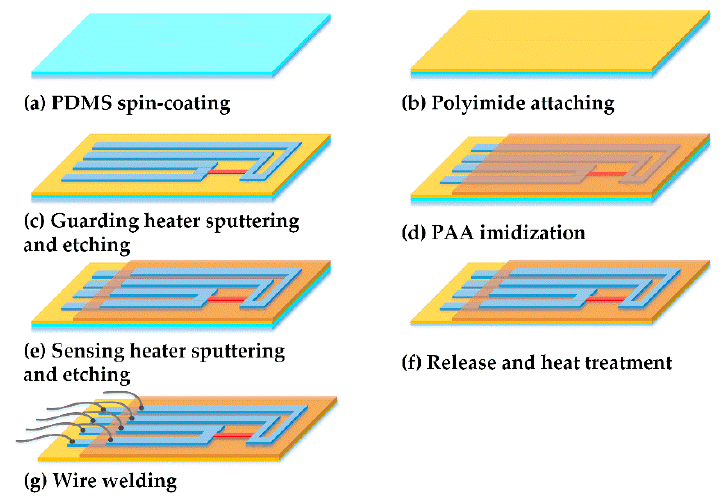
Figure 3. The fabrication processes for a flexible dual-layer hot film sensor.